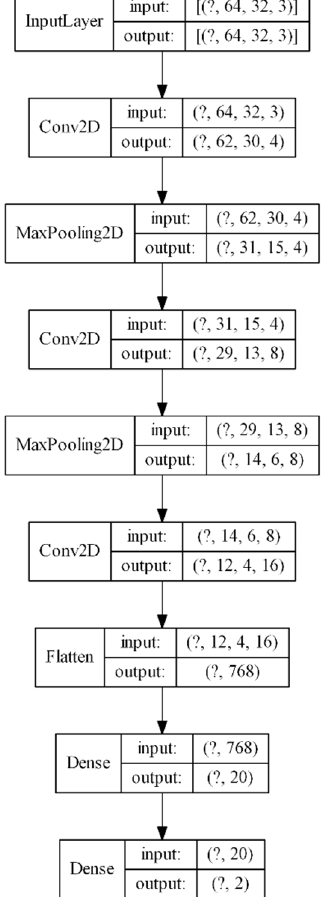
Figure 5. Design of the used convolutional neural network image.